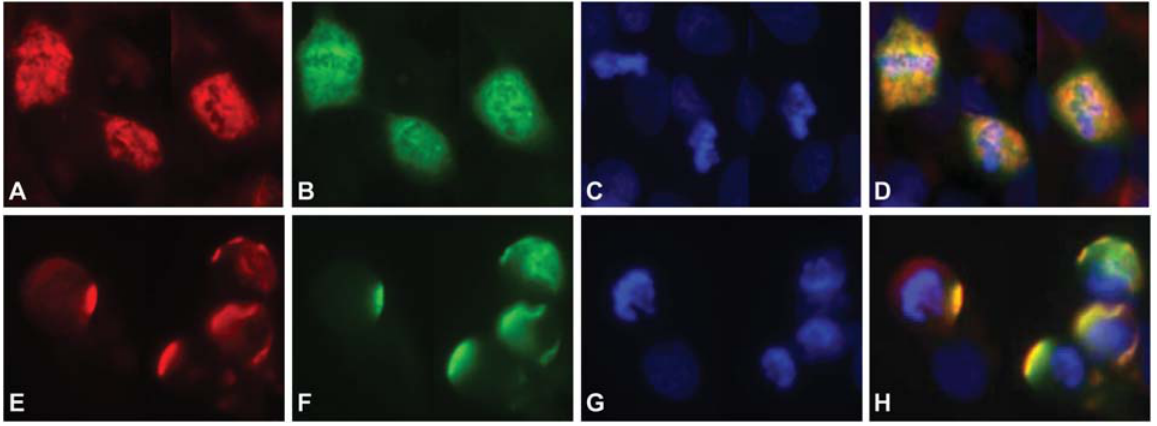
Figure 3 Colocalization of phosphorylated Akt with cytoskeletal intermediate filaments. Immunofluorescence staining of keratin 18 (A, E), phosphorylated Akt (T308) (B, F), nuclei with Hoechst dye (C, G) and merge (D, H) in hepatocellular carcinoma HepG2 cells during mitosis (A–D) and upon toxic stress